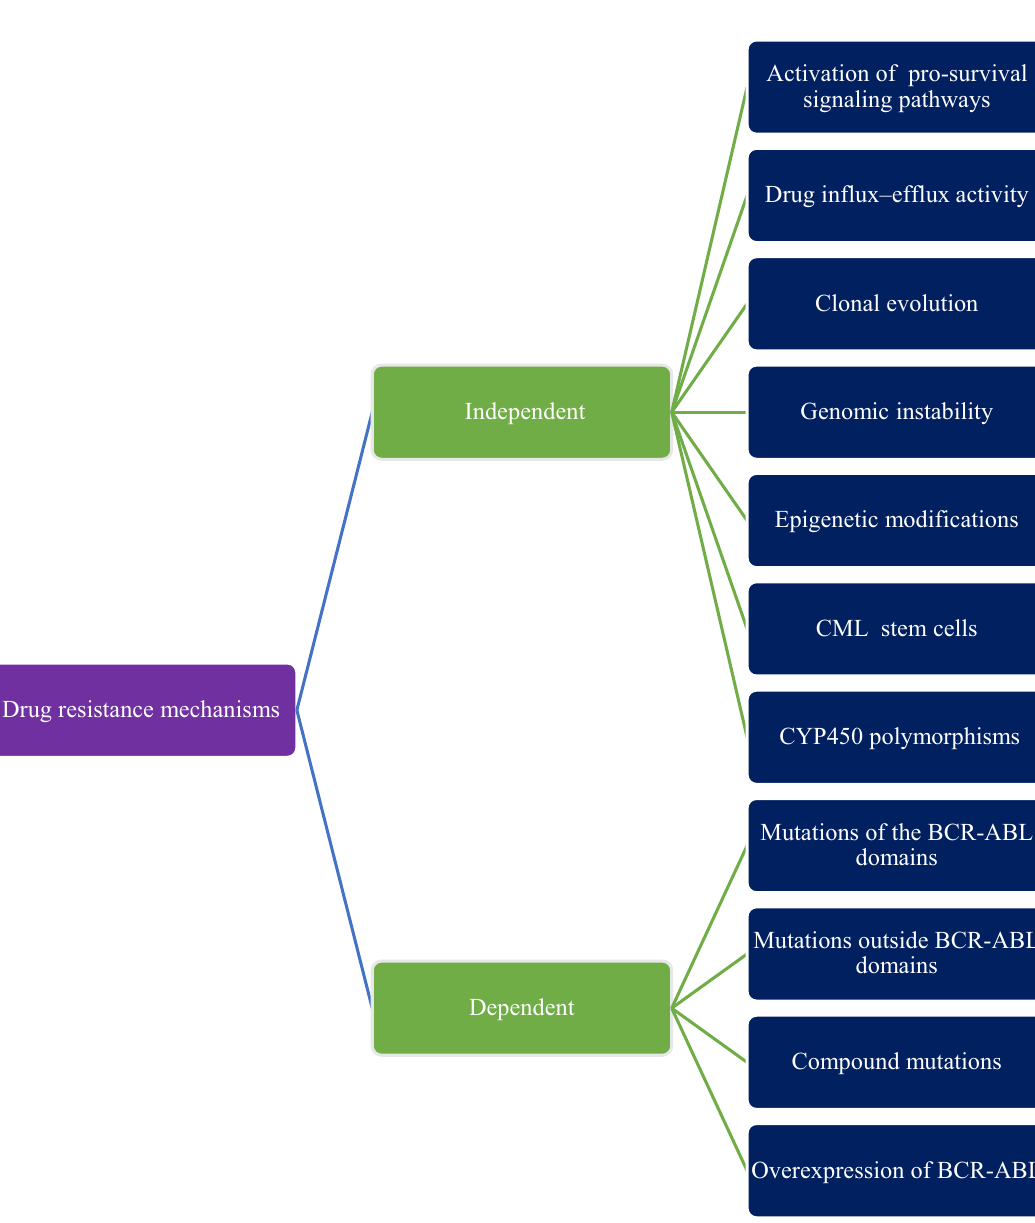
Fig. 1 Drug resistance mechanisms which are divided into two categories: BCR-ABL-dependent mechanisms and BCR-ABL-independent